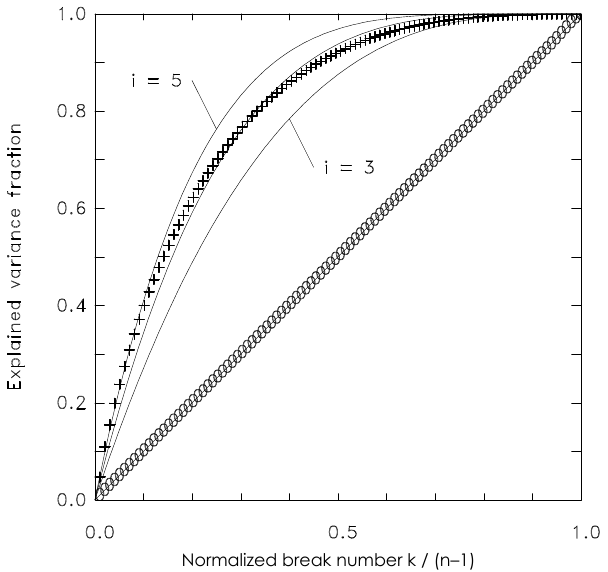
Figure 3. External variance as a function of the tested number of breaks for random (0) and optimum segmentations ( + ). The latter can be approximated by Eq. (6): auxiliary lines for exponents of 3, 4, and 5 are given additionally.